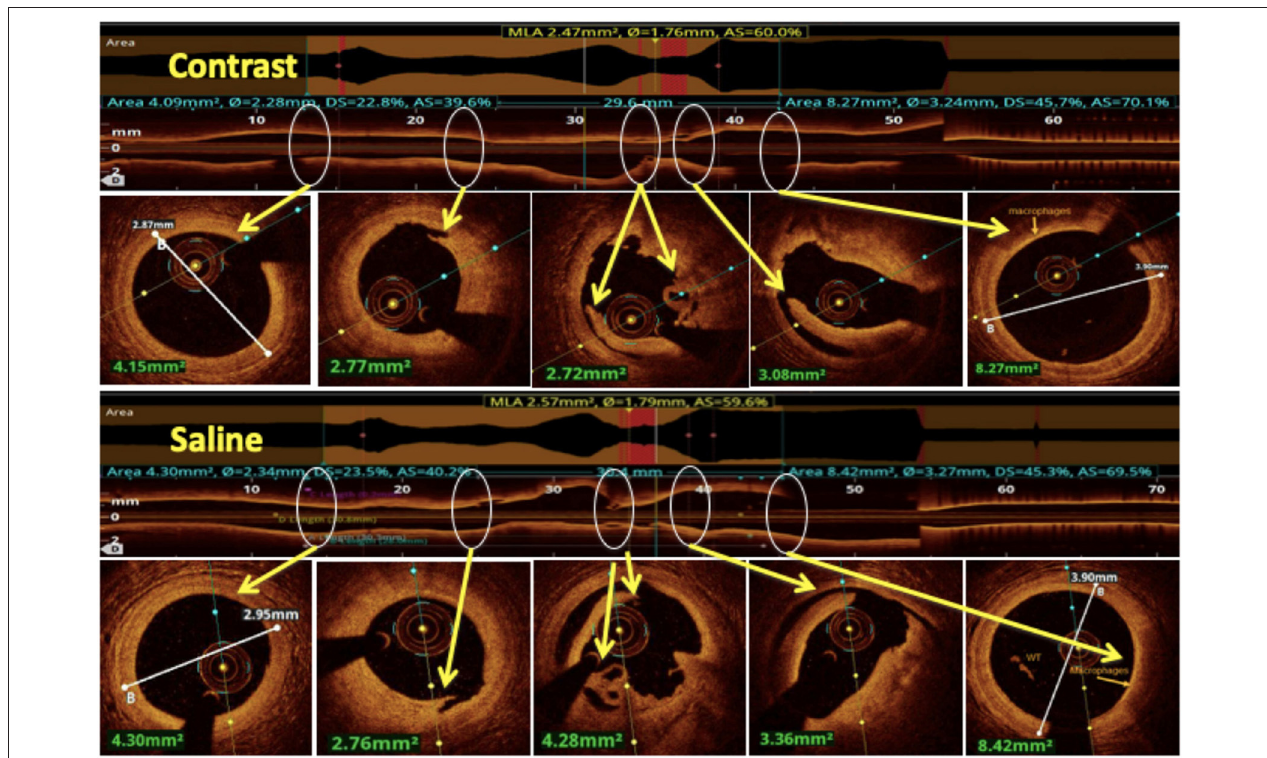
FIGURE 10 | Comparison between saline and contrast OCT. The upper panel shows pre-PCI run of RCA using contrast as a flushing media and in the lower panel the same vessel is imaged using saline as a flushing media for OCT and compared for image quality. All the lesion morphologies (including plaque rupture, dissections, recanalized thrombus, and macrophages) seen in contrast OCT are clearly seen with saline OCT (marked by yellow arrows at the same